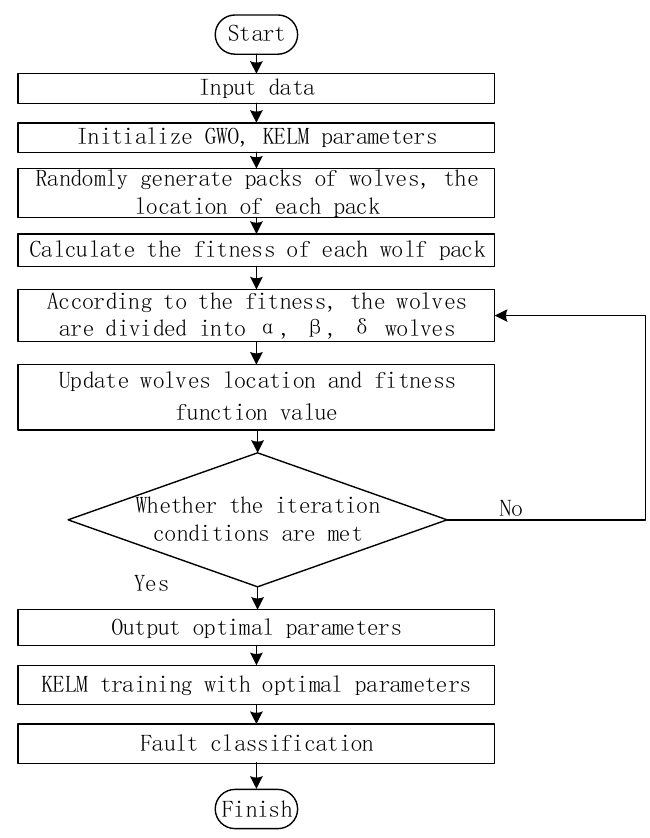
Figure 3. Flow chart of the proposed GWO-KELM method.